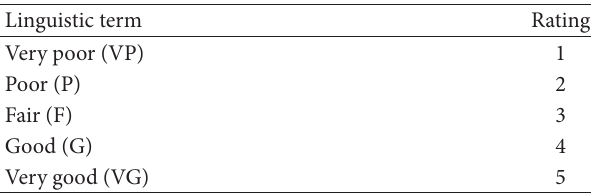
Table 5: Linguistic variables for alternatives’ rating.